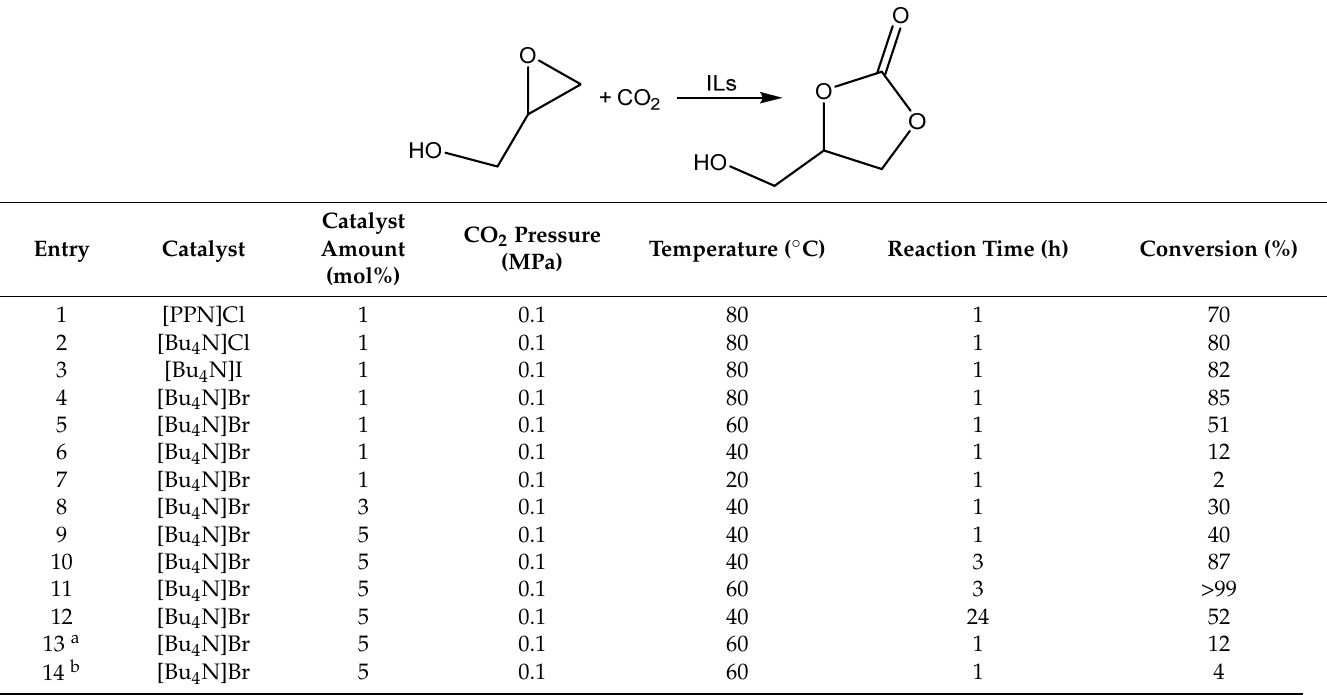
Figure 9. Structure of bis(triphenylphosphoranylidene)ammonium halide (PPNX) [73]. Table 17. Cycloaddition of CO 2 to glycidol producing hydroxymethyl ethylene carbonate (HMEC) [74].